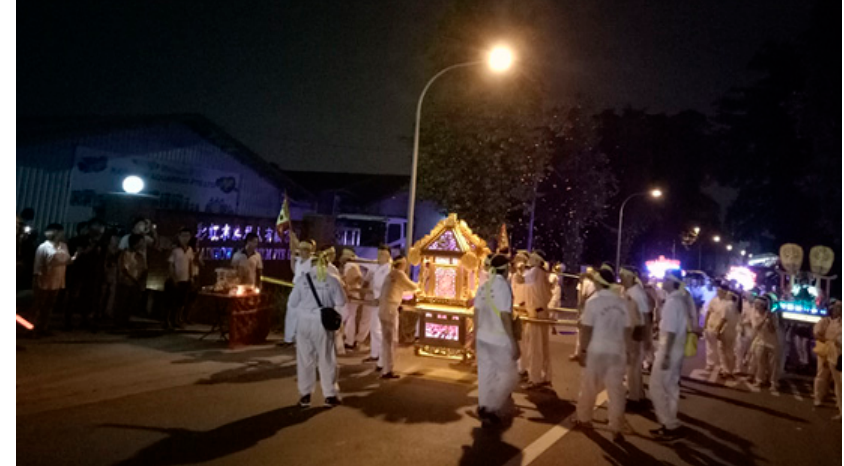
Figure 9. Palanquin-bearers pay respects at the altar in front of the Rainbow Aquarium.